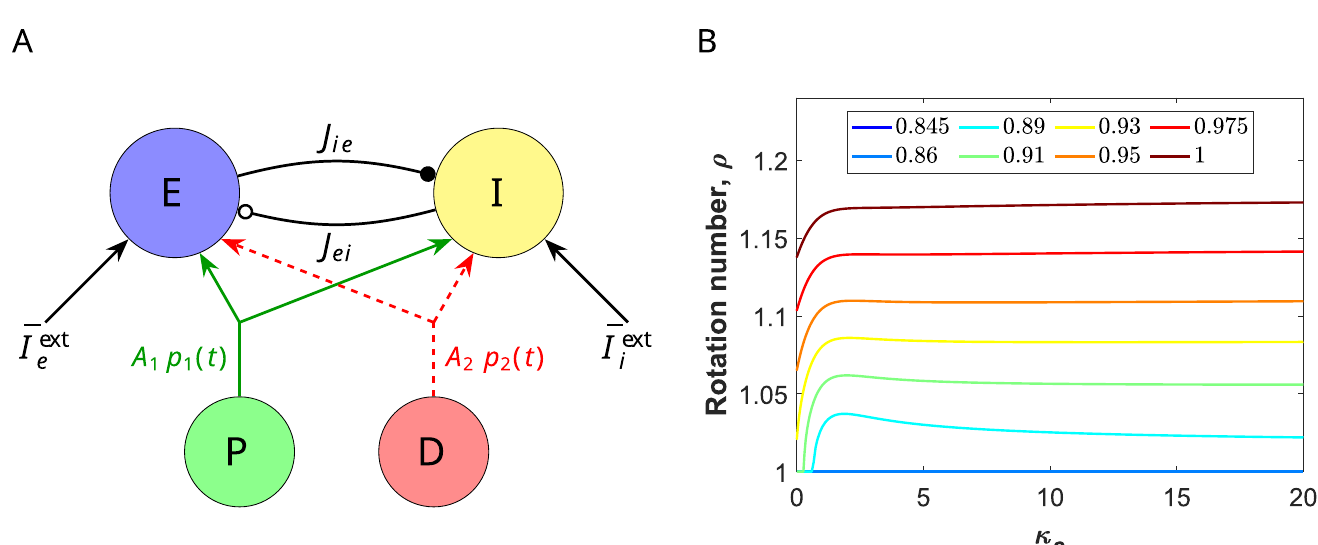
Fig 5. Effect of an identical frequency distractor in the network entrained by the primary stimulus. (A) Schematic representation of an E-I cortical neural network (PING interplay) receiving two oscillatory inputs from different sources: the primary input A 1 p 1 ( t ) (green circle) and the distractor one A 2 p 2 ( t ) (red circle). (B) Rotation numbers ρ of the stroboscopic map (9) for a perturbation consisting of a primary input and a distractor. Both inputs are modeled by means of a von Mises distribution, have the same amplitude factor A 1 = A 2 = 0.1 and the same period T = T 1 = T 2 but phase-shifted. The coherence for the primary is fixed at κ 1 = 2. We vary the distractor coherence κ 2 ( x -axis) and the period T , so that the values T / T � (color legend) are distributed along the 1:1 plateau for κ 1 = 2 (the oscillator and the primary stimulus support a 1:1 phase-locking relationship). If ρ = 1, the entrainment by the primary stimulus is preserved despite the presence of the distractor, otherwise, it breaks